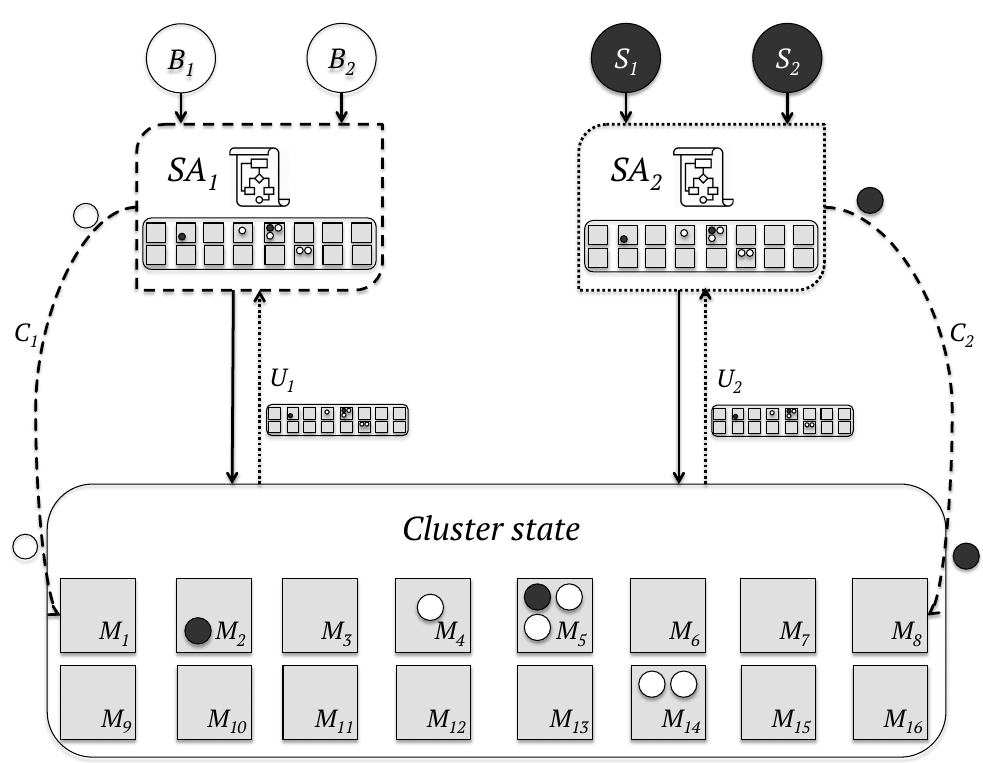
Figure 3. Shared-state scheduler architecture. U, cluster state update [52].